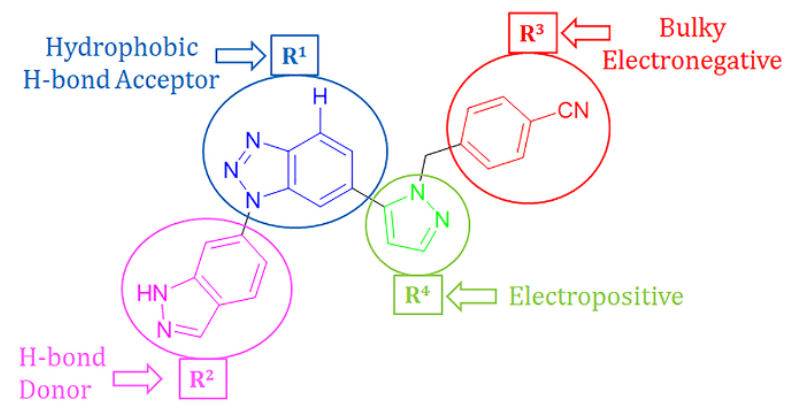
Figure 7. The design strategy for CD73 non-nucleotide small inhibitor design.